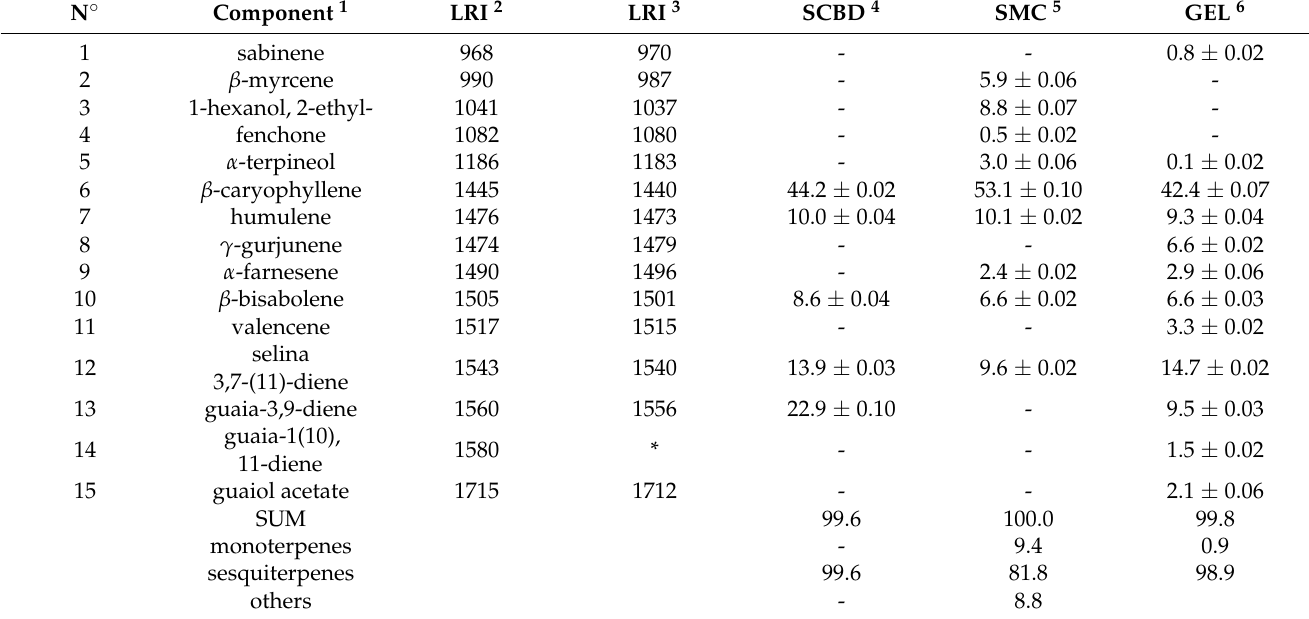
Table 1. Chemical volatile composition (percentage mean value ± standard deviation) of C. sativa